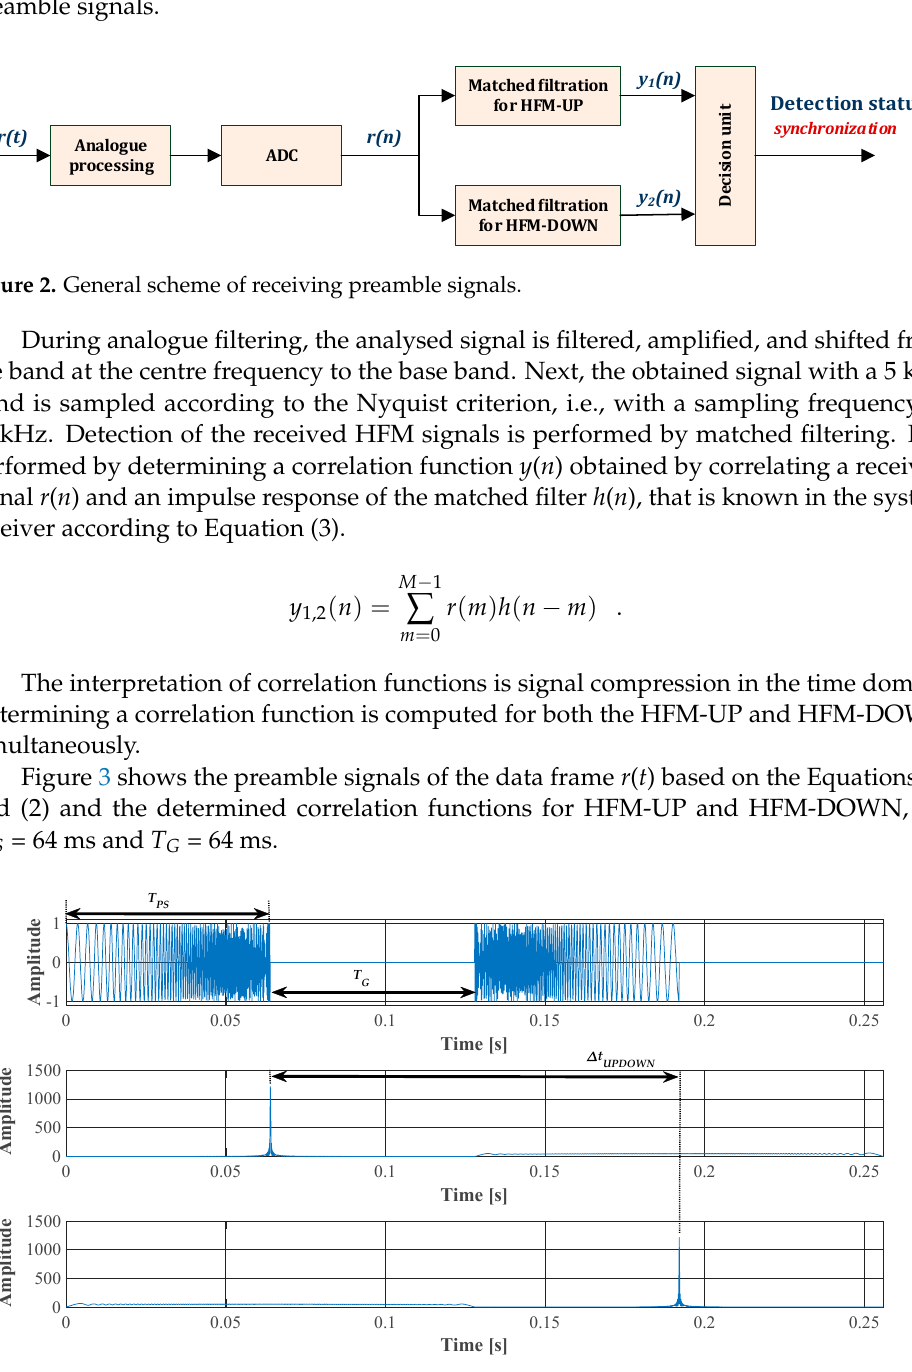
Figure 3. Frame preamble signals and the determined correlation functions for the received signal with the pattern of HFM-UP and HFM-DOWN signals ( T PS = 64 ms, T G = 64 ms, SNR = +20 dB). The aim of using matched filtering is to enhance the receiver input signal-to-noise ratio (SNR r ). The output signal-to-noise ratio of the receiver SNR y is determined by mul- tiplying SNR r by product B · T , where B is bandwidth of the signal and T is an equal time period, based on Equation (4).